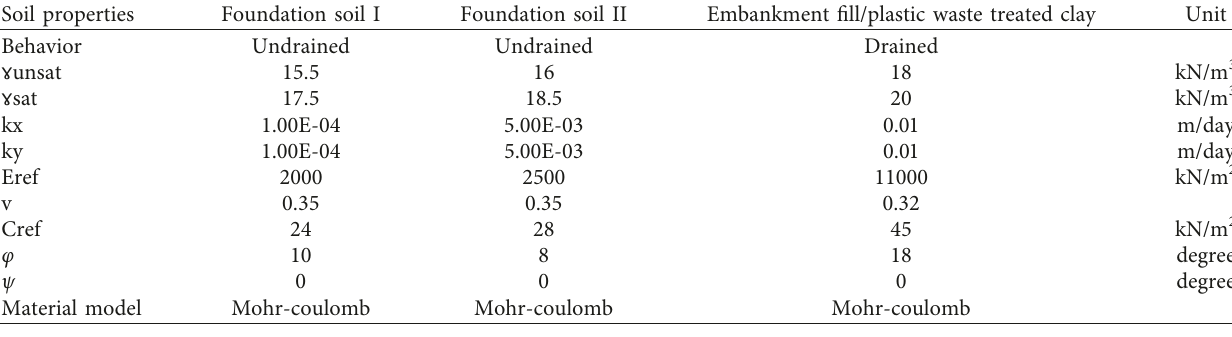
Table 3: Material properties of embankment and foundation soils.